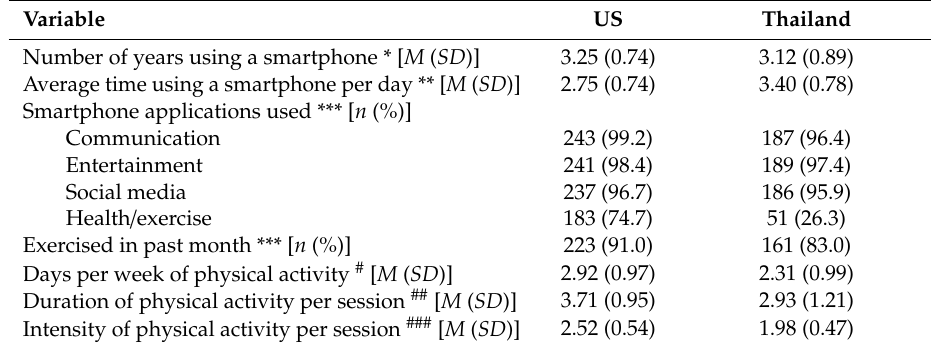
Table 2. Means, standard deviations, and percentages for smartphone use and physical